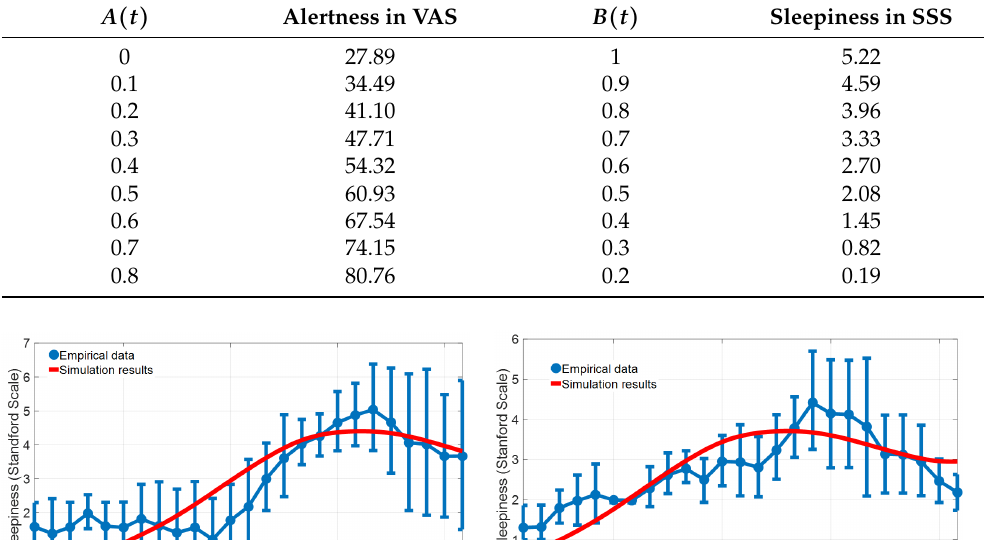
Table 1. The relationship of alertness in VAS (mm), B ( t ) , and sleepiness in SSS with A ( t ) .